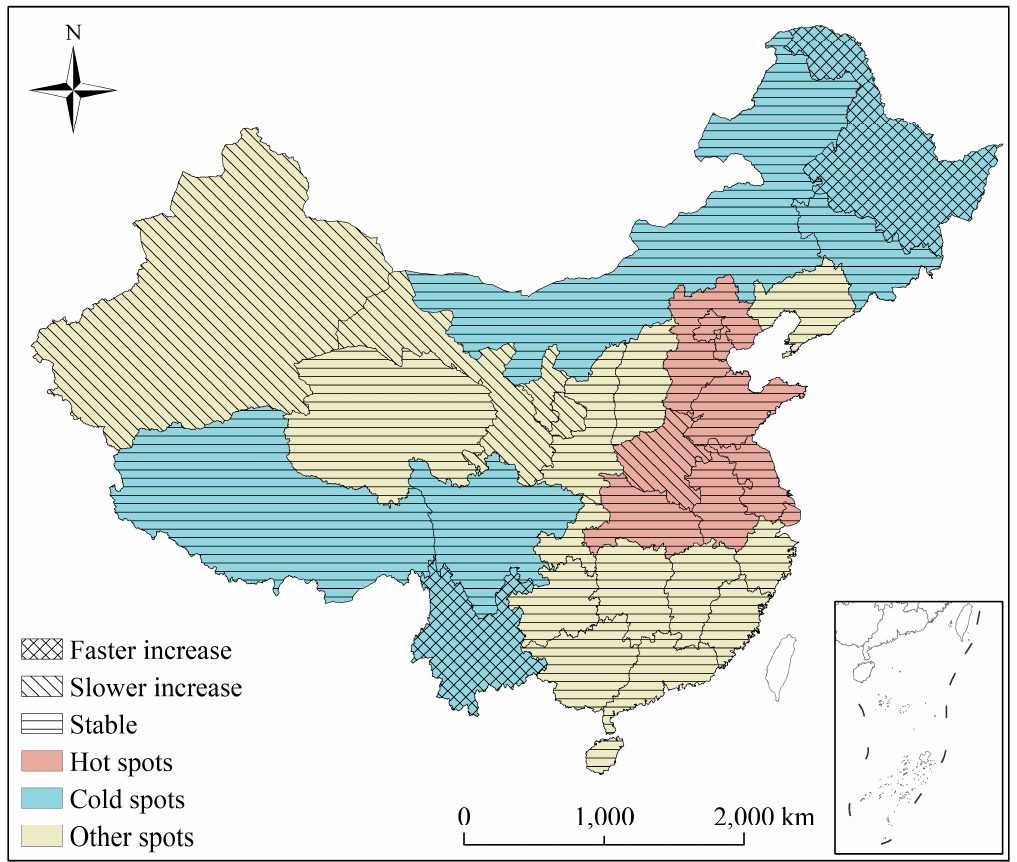
Figure 5. Spatial distribution of high/low ‐ risk regions of PM 2.5 concentrations in China.